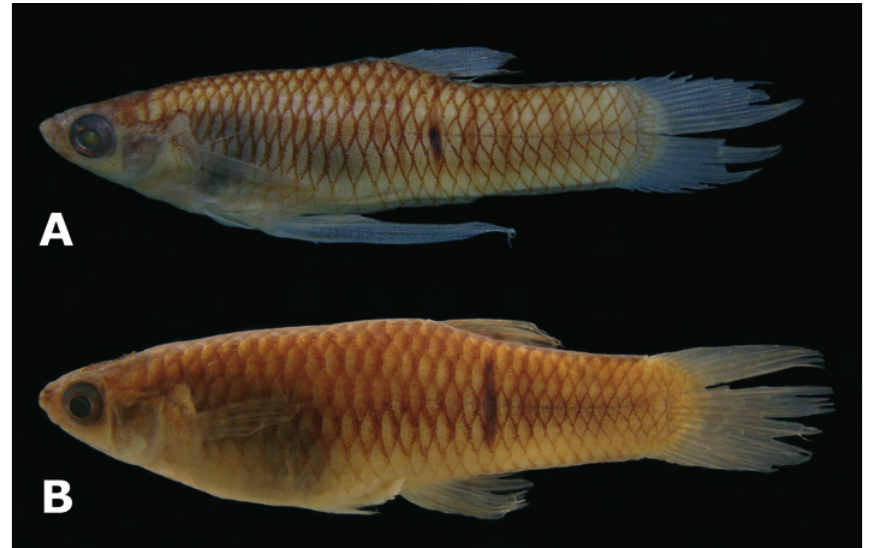
Fig. 44. Phalloceros anisophallos . (A) Holotype, male, 28.2 mm SL, MCP 30403, rio São Roque nearby road BR 101 N of Parati, Parati, Rio de Janeiro, Brazil; (B) paratype, female, MCP 12603, 41.3 mm SL, collected with the